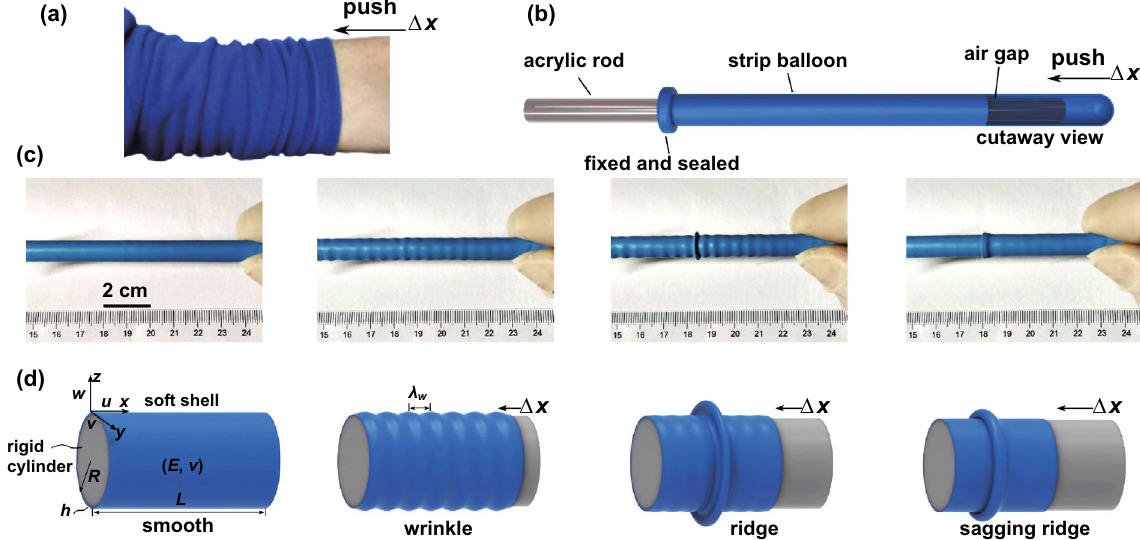
Fig. 8 Surface buckling of a soft cylindrical shell supported by a stiff cylinder. a Buckling structures observed when a sleeve is pushed up. b Experiments of a slidable latex balloon on an acrylic rod. c , d Photographs and schematic show the morphology evolution by increasing the compression from the right side: initial configuration, wrinkle, ridge, sagging ridge, respectively [136]. Copyright 2018 American Physical Soci-